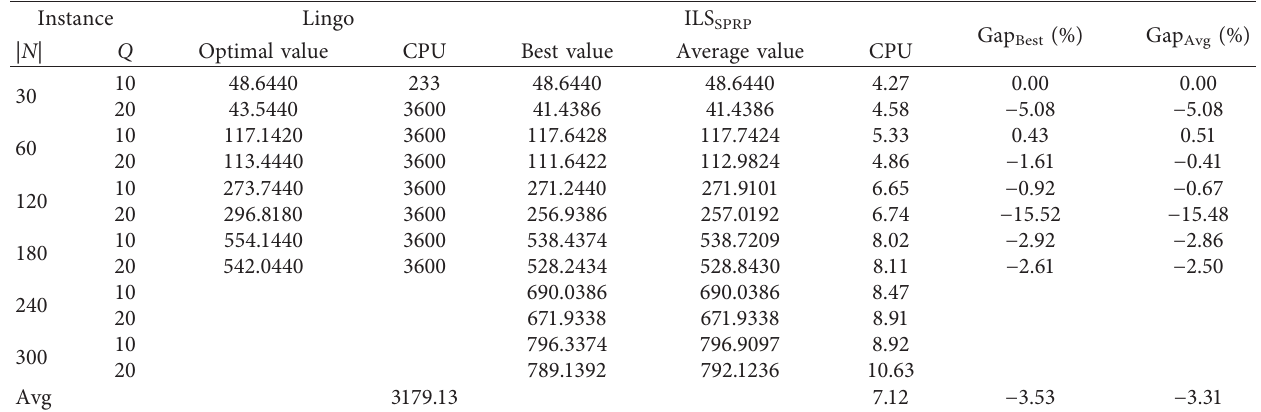
Table 3: Result comparison of Lingo and ILSSPRP ( T � 14400s).